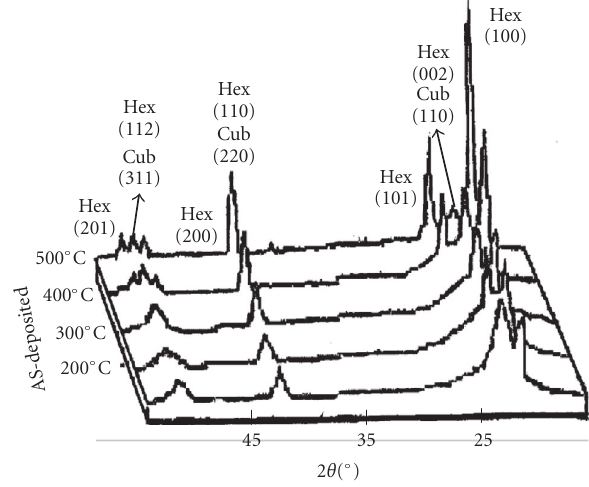
Figure 5: The X-ray di ff raction (XRD) of the CdS films at di ff erent annealing temperatures. Intensity is in arbitrary